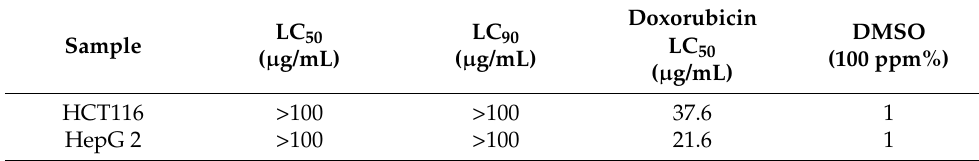
Table 5. Cytotoxic activity of L. libyca against human cell lines.